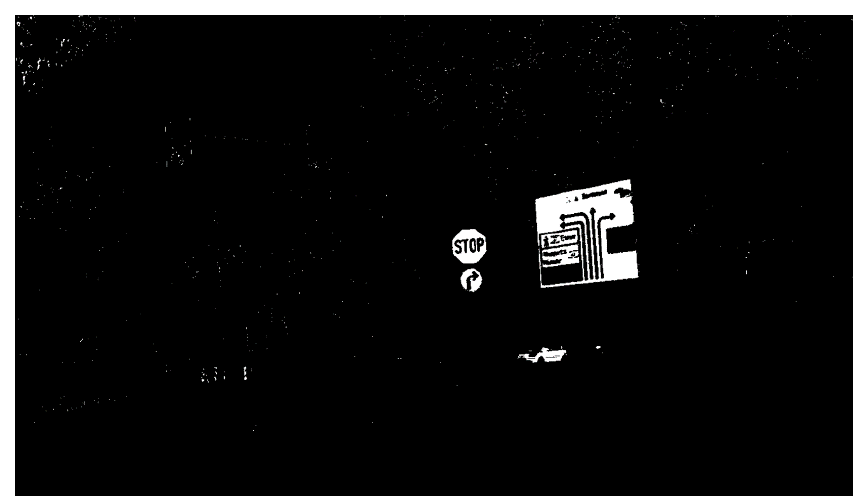
Figure 3. A test image and its enhanced version (gray scale).